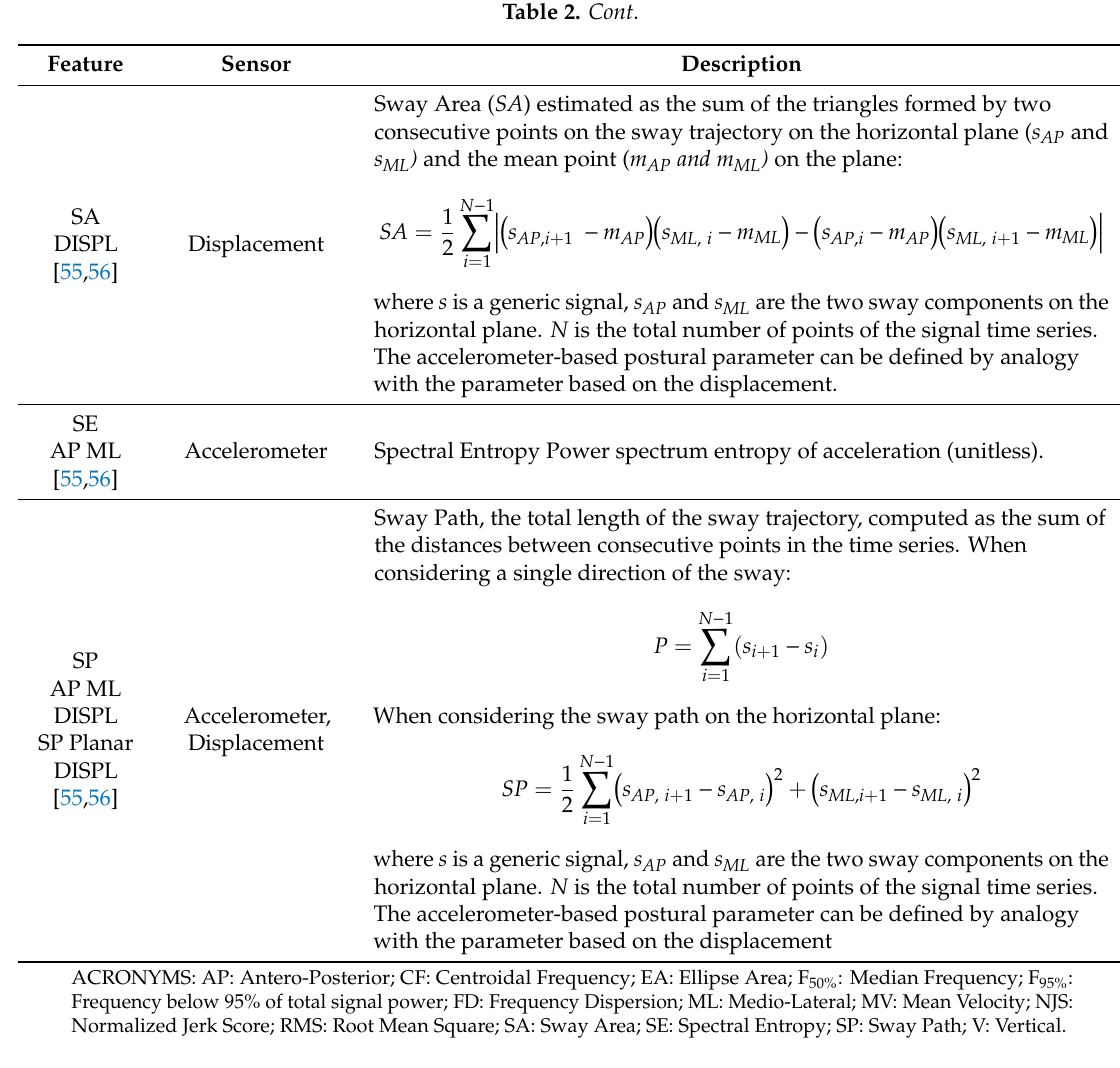
Table 3. Sensor-based features extracted from the 7MW